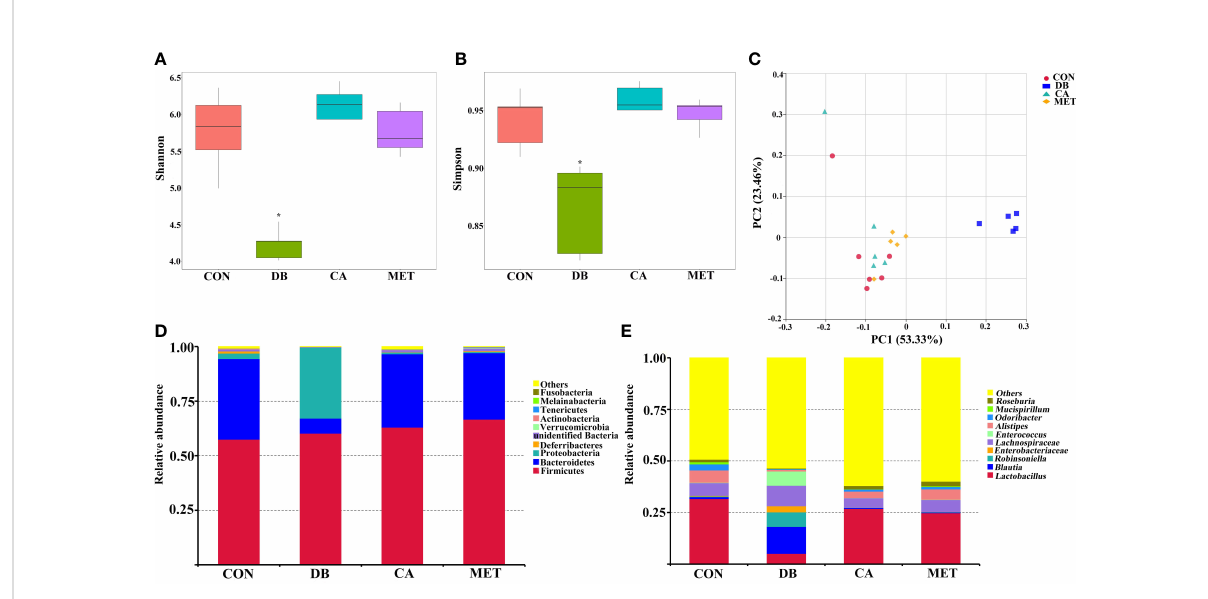
FIGURE 5 Effects of chlorogenic acid on cecal microbe composition in diabetic db/db mice. (A) Shannon index; (B) Simpson index; (C) PCoA plot of the microbiota based on an unweighted UniFrac metric; (D) Relative abundance of predominant bacteria at the phylum level; (E) Relative abundance of predominant bacteria at the genus level. * P < 0.05 (signi fi cant difference between mice in the DB group and mice in the other